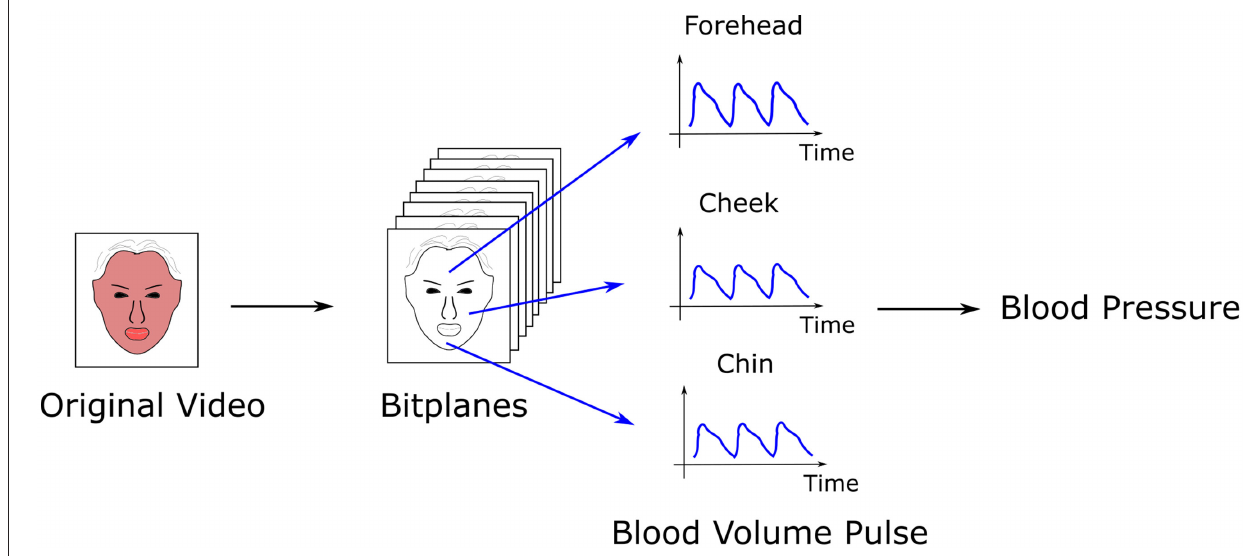
FIGURE 2 | Calculation of blood pressure (BP) by transdermal optical imaging (TOI). A machine learning algorithm selects the bitplanes from a video with the highest signal for hemoglobin, from which the blood volume pulse is extracted from multiple facial regions (17 regions total). Features of the pulse are input into a multilayer perceptron to calculate